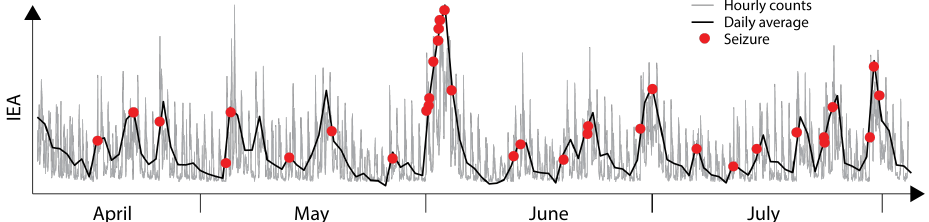
Figure 3. Ultra-long term recording of human brain activity with intracranial electrodes over months to years demonstrates that epileptic seizures do not occur randomly. The interictal epileptiform activity (IEA)—here quantified by a composite measure of EEG signal features—is characterized by multi-dien periodicities. Epileptic seizures are more likely to occur during times of increasing and/or increased